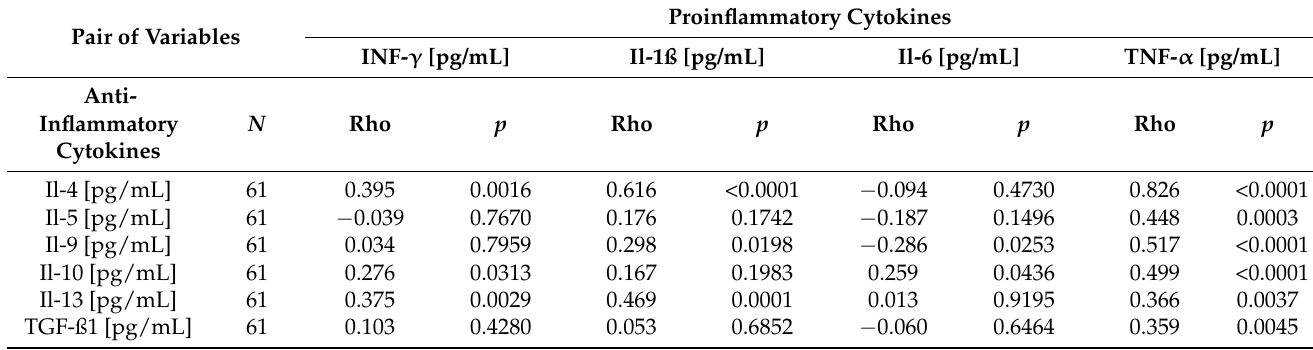
Proinflammatory